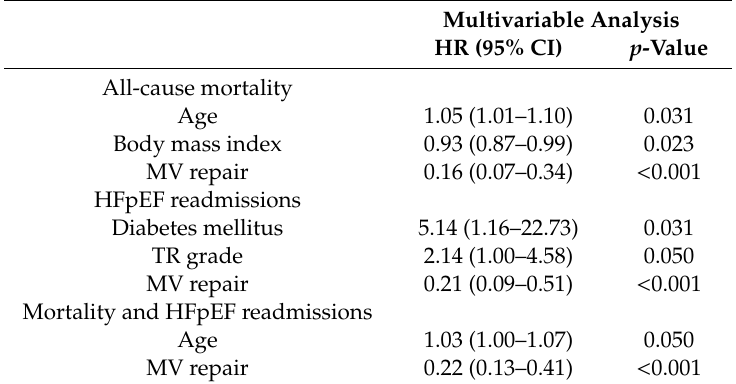
Table 2. Predictors of all-cause mortality, HFpEF readmissions, and their